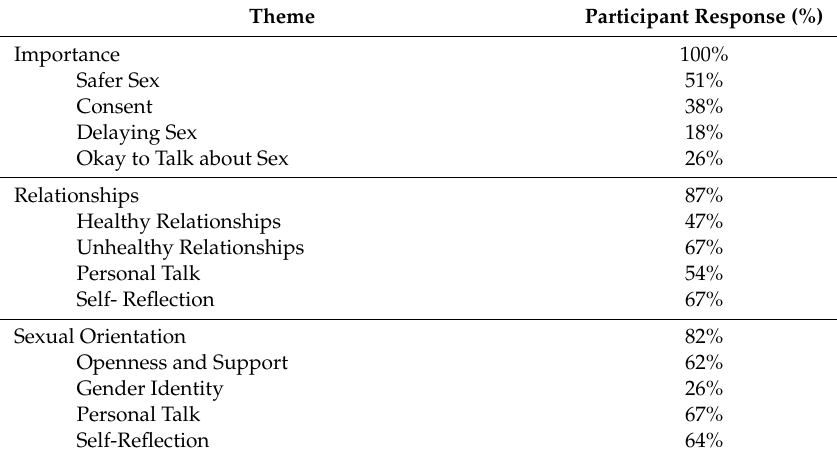
Table 1. Identified Themes and Subthemes of Conversations between Extended Family Participants and Teens ( N =